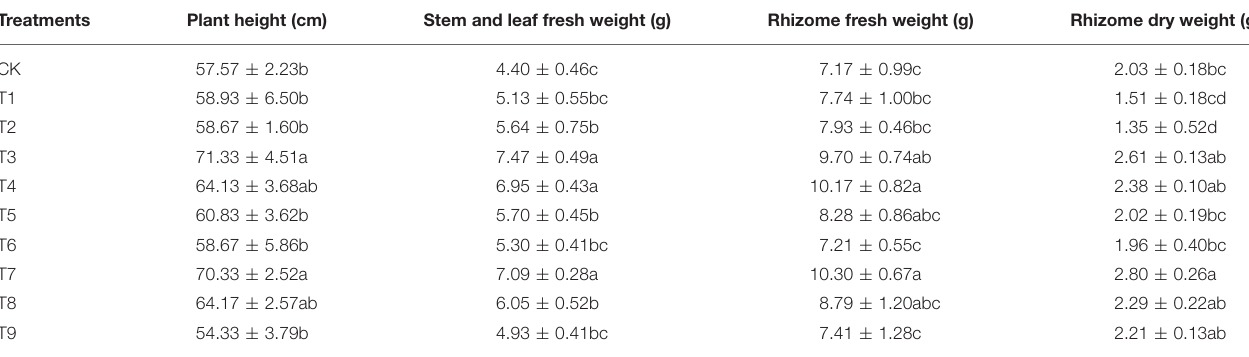
TABLE 2 | Effects of NPK combined application on growth indexes of ginseng. Treatments